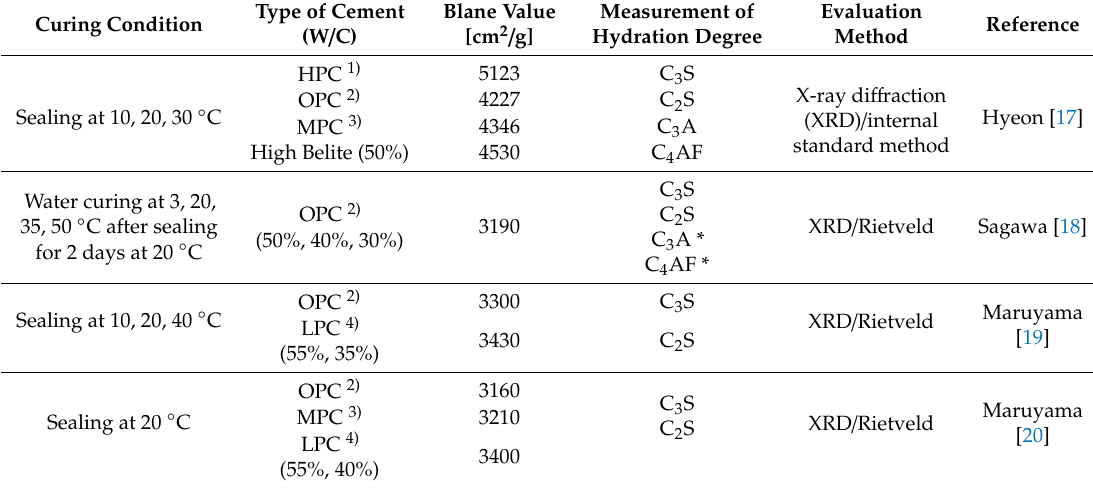
Table 1. Experimental conditions in the past studies using various types of portland